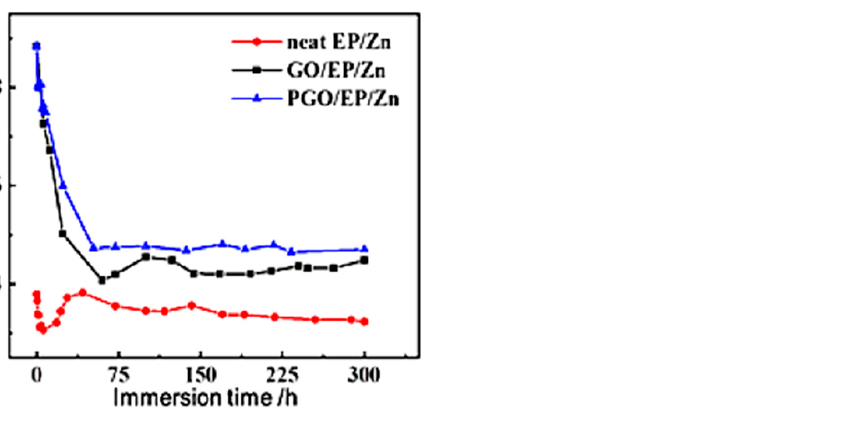
Figure 8. The dependence of the impedance for neat EP/Zn, GO/EP/Zn, and PGO/EP/Zn coatings on immersion time in 3.5 wt.% NaCl solution.